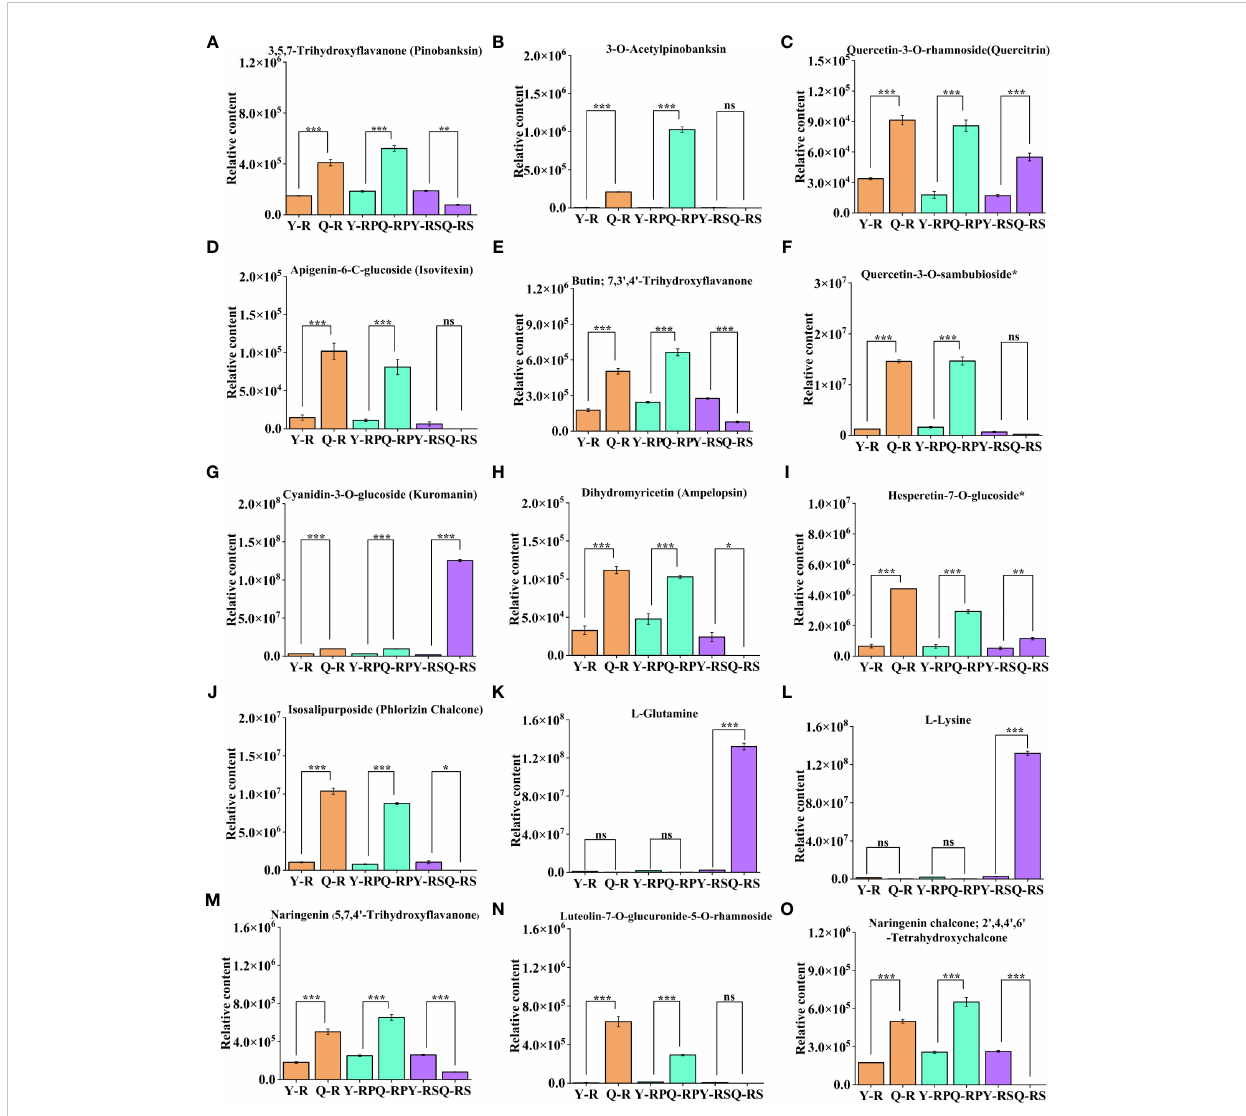
FIGURE 10 Difference in the relative content of thirteen selected bioactive fl avonoids and two amino acids and their derivatives in two plateaus. 3,5,7- Trihydroxy fl avanone (Pinobanksin) (A) , 3-O-Acetylpinobanksin (B) , Quercetin-3-O-rhamnoside(Quercitrin) (C) , Apigenin-6-C-glucoside (Isovitexin) (D) , Butin; 7,3',4'-Trihydroxy fl avanone (E) , Quercetin-3-O-sambubioside* (F) , Cyanidin-3-O-glucoside (Kuromanin) (G) , Dihydromyricetin (Ampelopsin) (H) , Hesperetin-7-O-glucoside* (I) , Isosalipurposide (Phlorizin Chalcone) (J) , L-Glutamine (K) , L-Lysine (L) , Naringenin (5,7,4'- Trihydroxy fl avanone) (M) , Luteolin-7-O-glucuronide-5-O-rhamnoside (N) , Naringenin chalcone; 2',4,4',6'-Tetrahydroxychalcone (O) . Bars indicate the s.d. of three replicates. “ ns ” means not signi fi cant, * p < 0.05, ** p < 0.01, *** p <